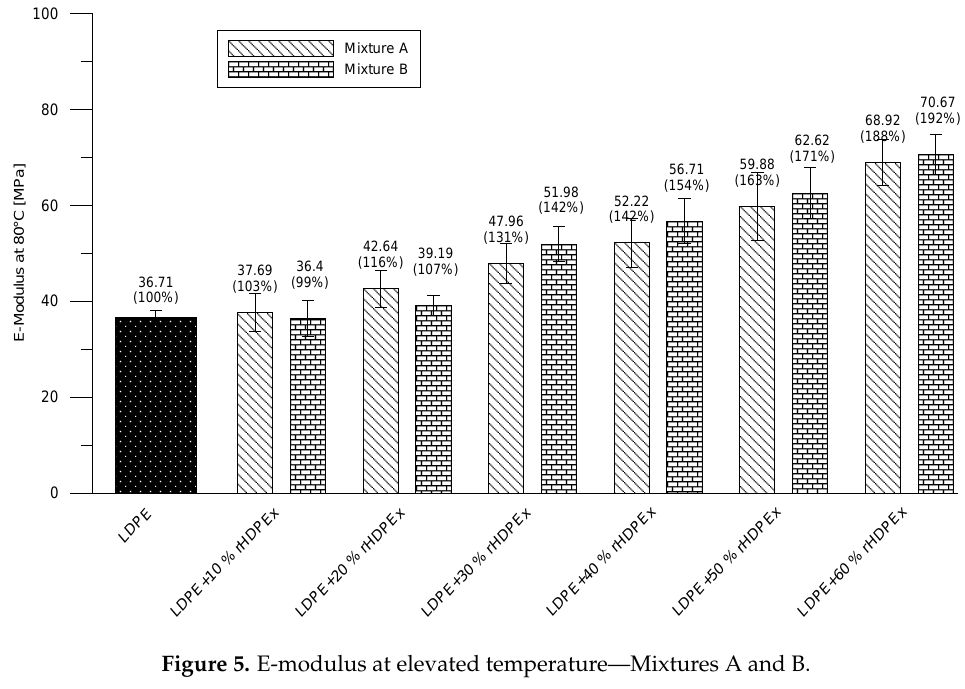
Figure 5. E-modulus at elevated temperature—Mixtures A and B.